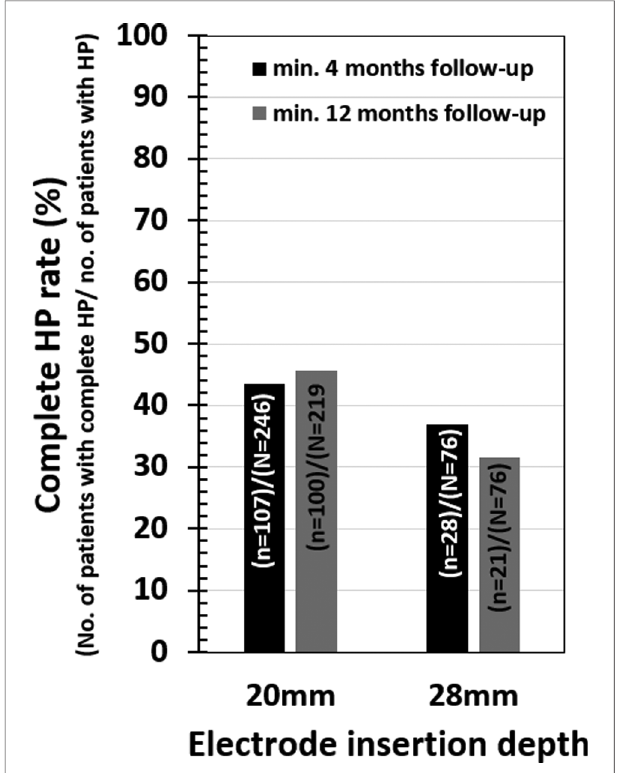
FIGURE 5 | Complete HP rates for two different electrode insertion